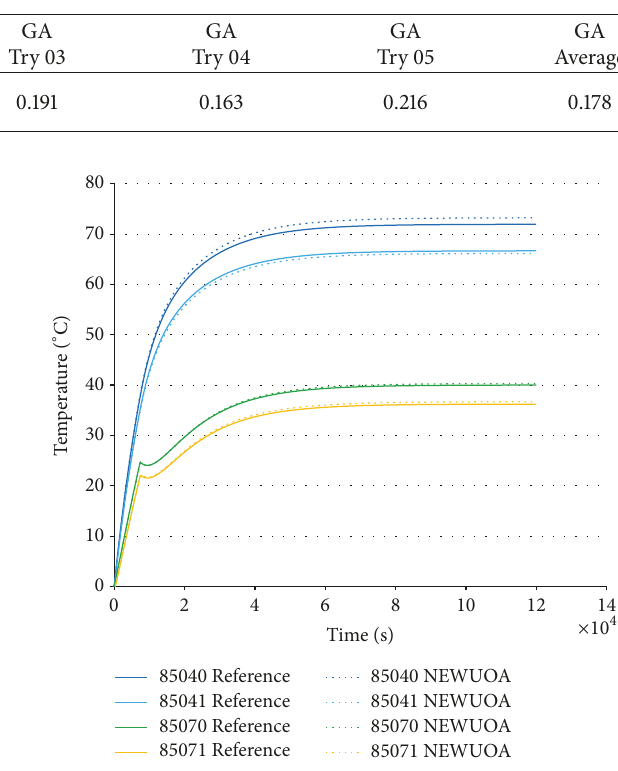
Table 6: Error values achieved with the GA for transient cases ( ∘ C).